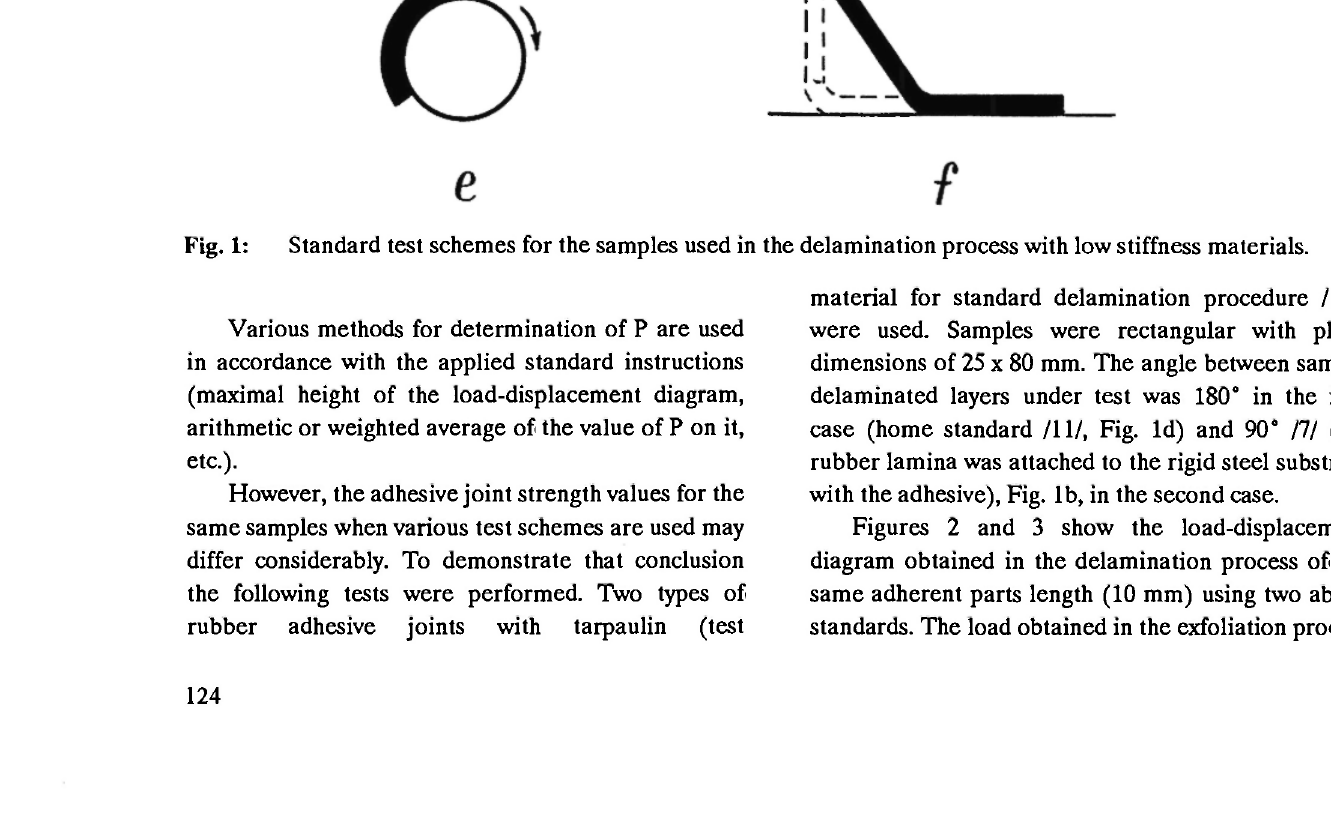
Fig. 1: Standard test schemes for the samples used in the delamination process with low stiffness materials.